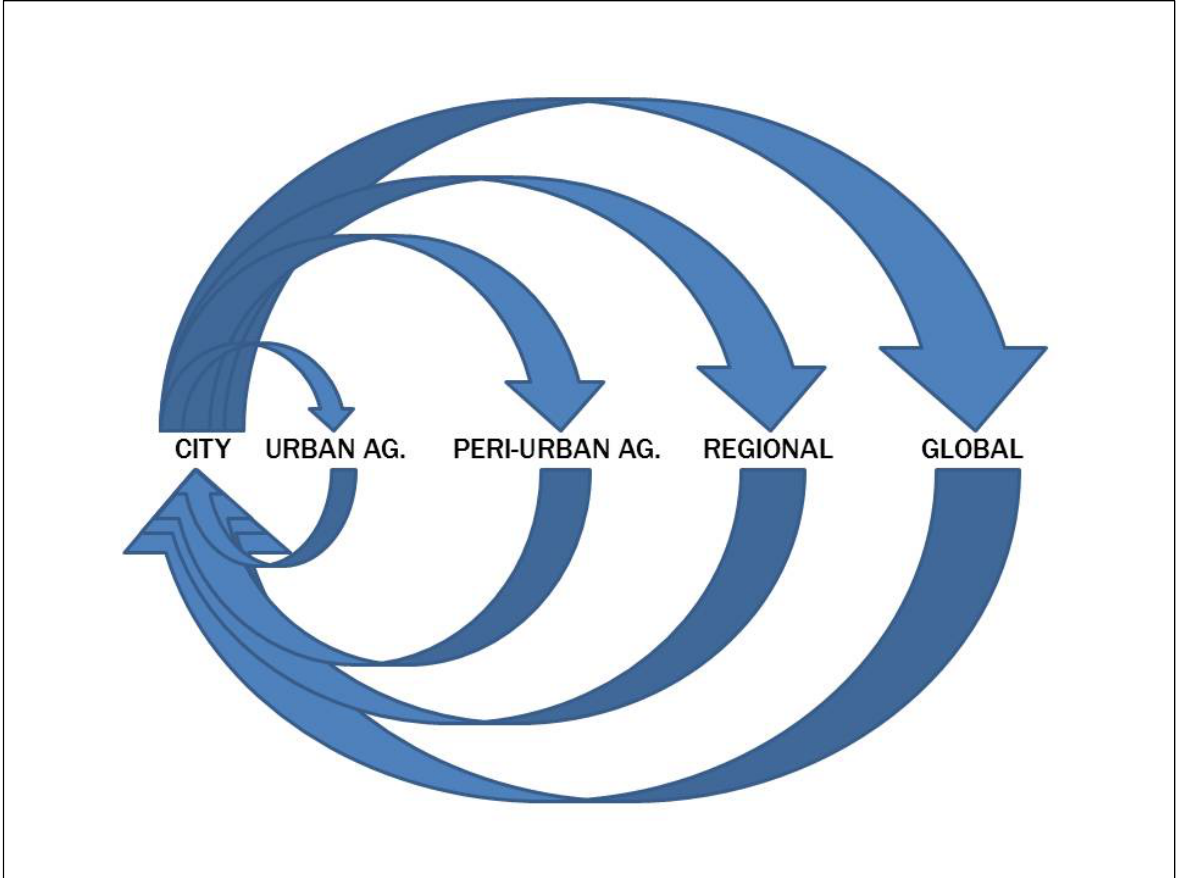
Figure 2. Feedback Loops in Various Scales of Food Supplies and Markets To Sustain Urban Food Supply and Rural